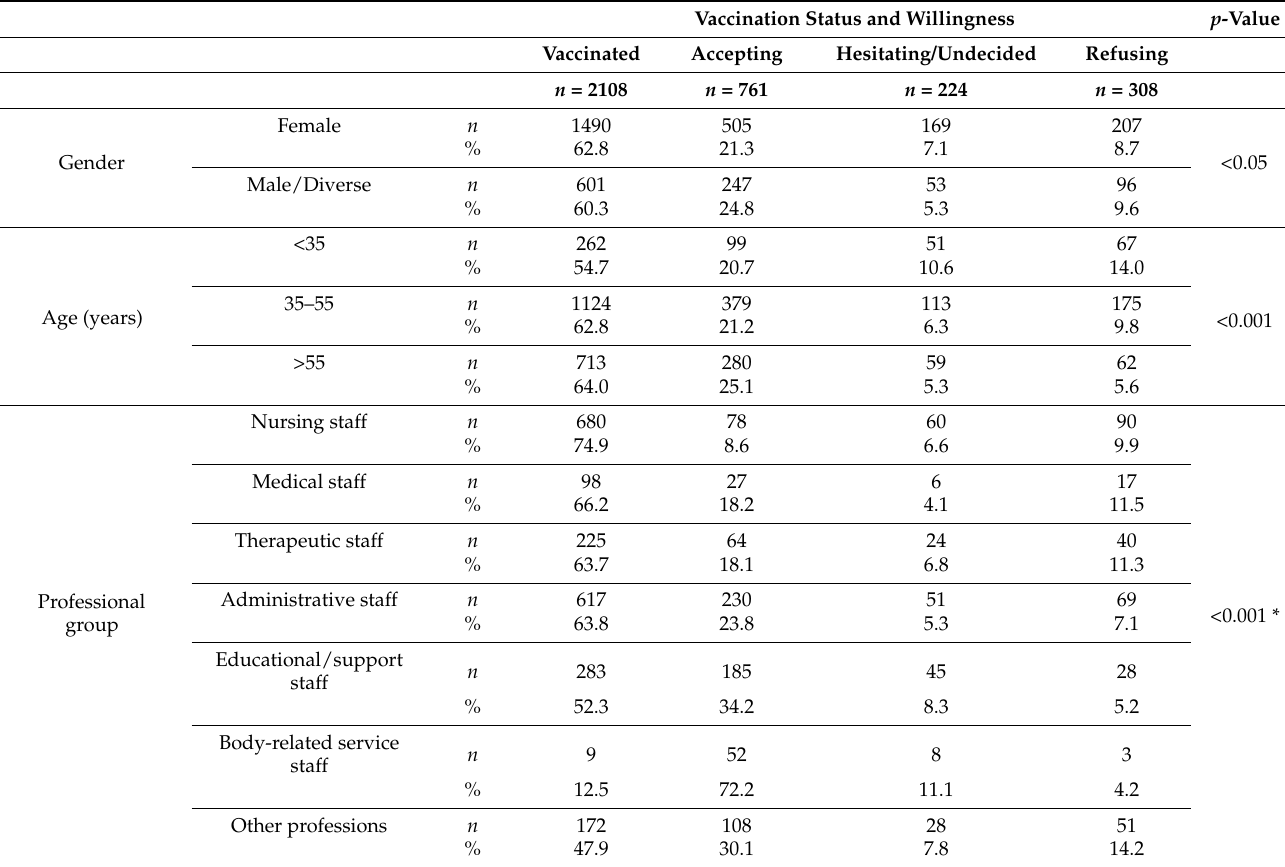
Table 2. Vaccination status and willingness of unvaccinated individuals for COVID-19 vaccination.